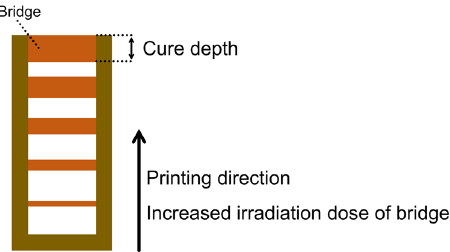
Fig. 6 Schematic illustration of the cure-depth characterization. A bridge model was printed for characterization by increasing the irradiation dose along the